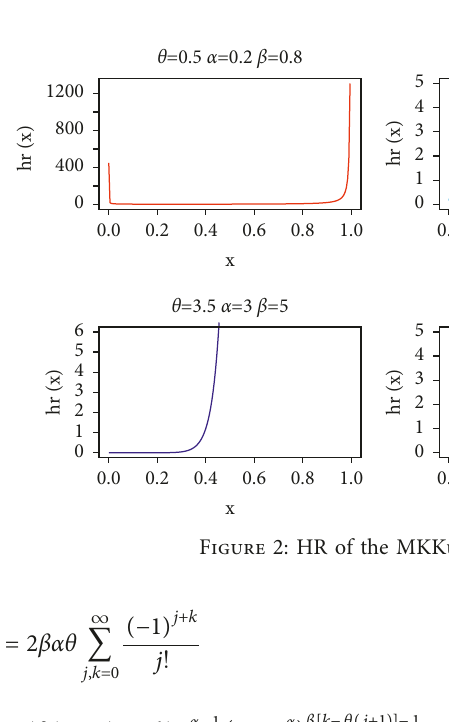
Figure 1: The PDF of the MKKu distribution for certain parameter values.